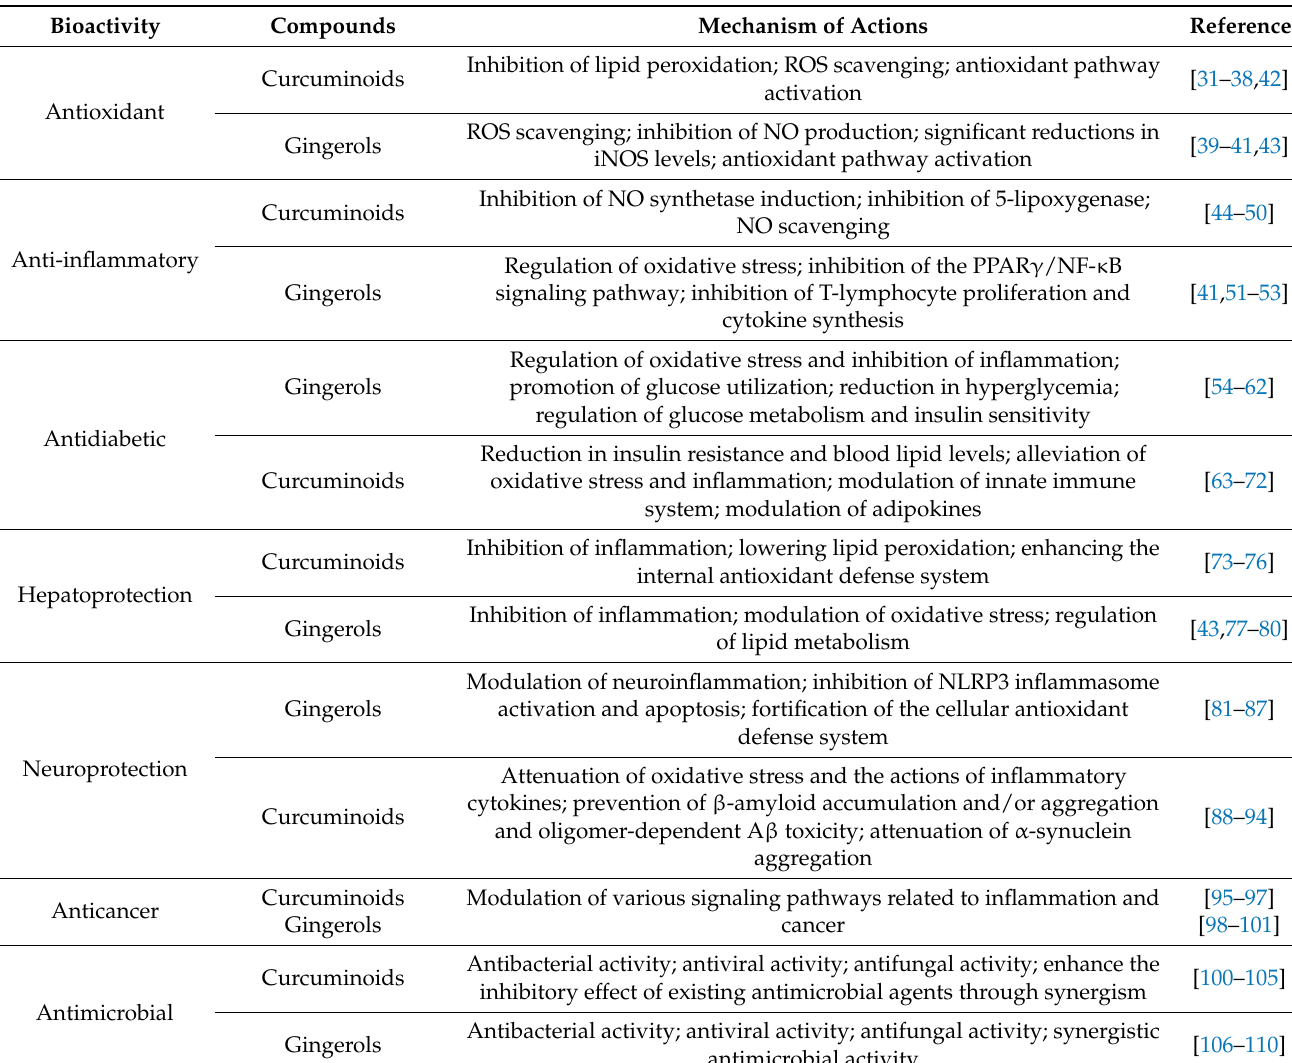
Table 2. Summary of notable bioactivities of the gingerols and the curcuminoids. iNO, inducible nitric oxide synthase; ROS, reactive oxygen species; NF- κ B, nuclear factor kappa B; NLRP3, NACHT, LRR and PYD domains-containing protein 3; PPAR γ , peroxisome proliferator-activated receptor γ